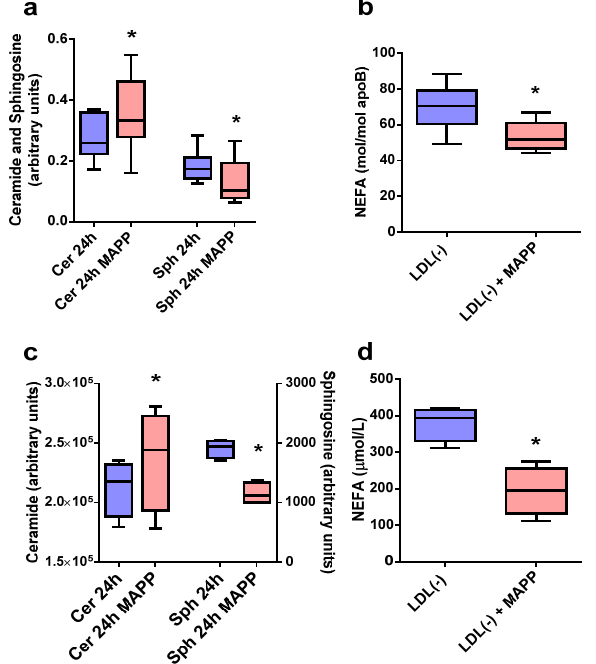
Figure 3. Effect of the ceramidase inhibitor MAPP on the formation of Cer, Sph, and NEFA in LDL( − ) after 24 h of incubation at 37 °C. ( a ) Cer and Sph content measured by TLC ( n = 9). ( b ) NEFA content measured via enzymocolorimetry ( n = 6). ( c ) Cer and Sph content measured by a lipidomic analysis ( n = 4). ( d ) NEFA content measured by a lipidomic analysis ( n = 4). * p < 0.05 versus LDL( − ) in the absence of MAPP.